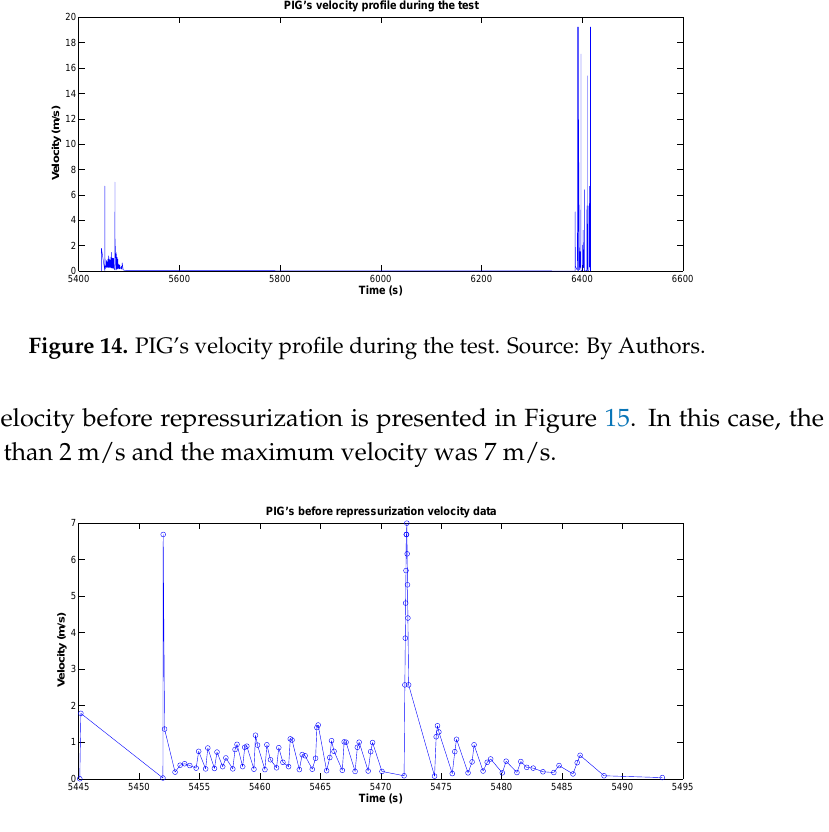
Figure 15. PIG’s before repressurization velocity data. Source: By